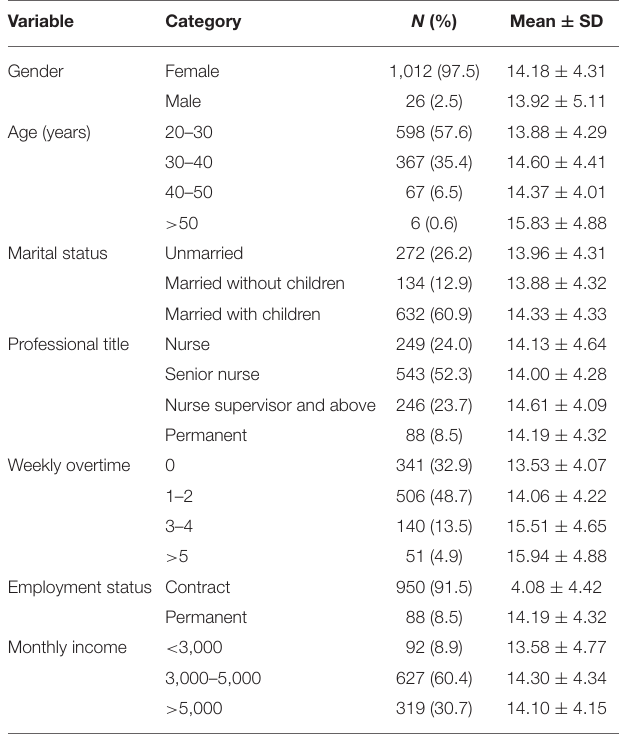
TABLE 1 | Demographic and working characteristics of nurses ( N = 1,038) and scores of presenteeism.